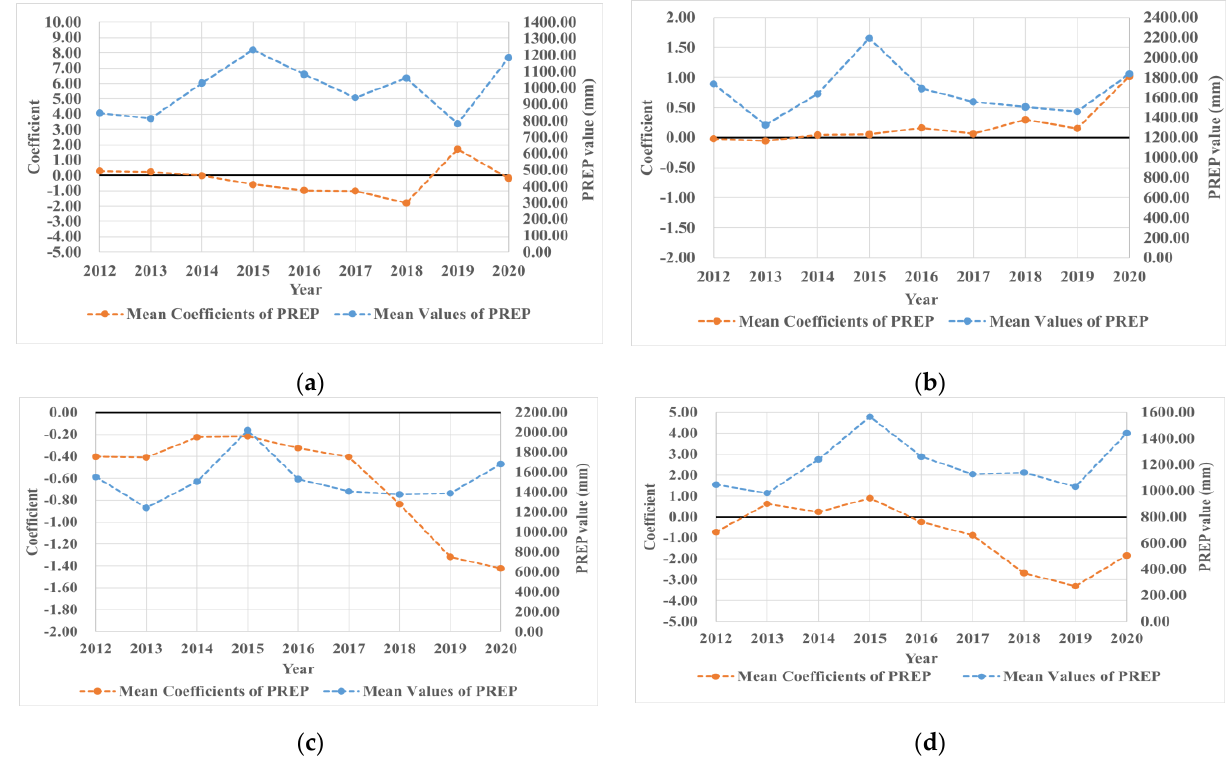
Figure 16. Temporal trends of mean PREP values and mean PREP coefficients in ( a ) Chuzhou; ( b ) Chizhou; ( c ) Xuancheng; ( d ) Ma’anshan .